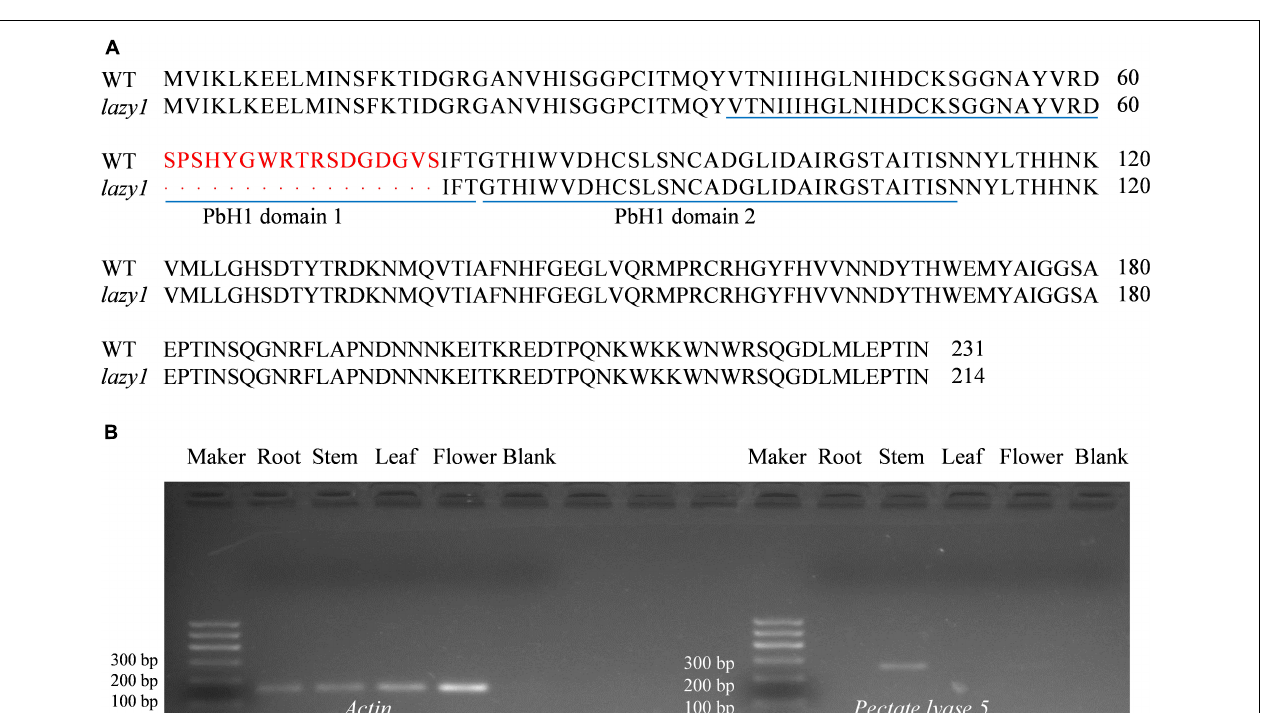
231-amino acid protein containing two pbH domains.